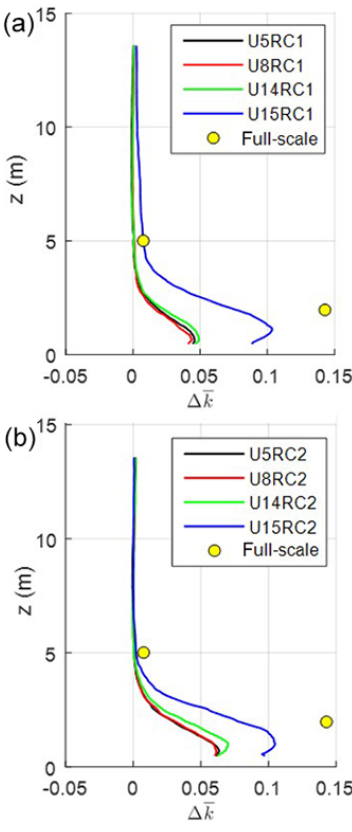
Vertical profiles of TKE increment (cid:49)k at M6 for (a) RC1 cases and (b) RC2